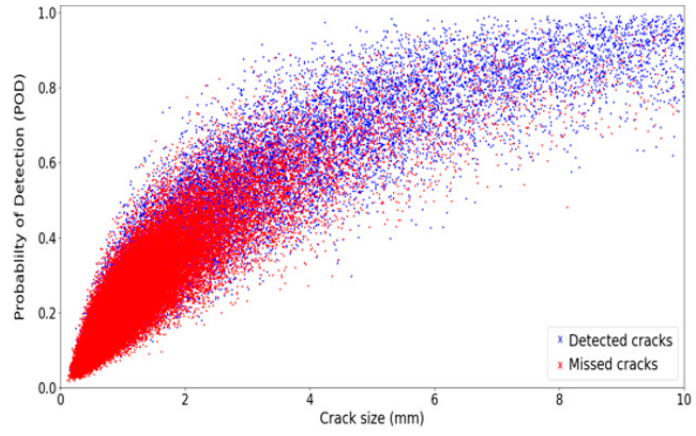
Figure 3. Detected/missed cracks obtained by implementing the detection criterion Figure 3. Detected / missed cracks obtained by implementing the detection